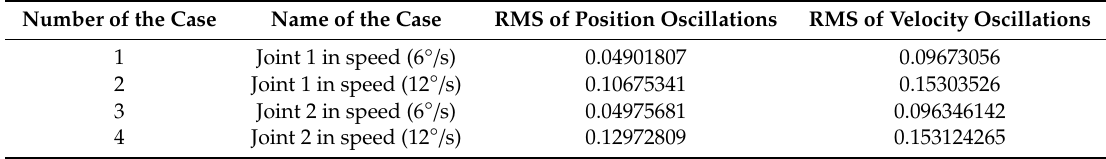
Table 5. The RMSE of both velocity oscillations and position oscillations at two speeds in joint 1 ( X -axis) and joint 2 ( Y -axis), (unit: ◦